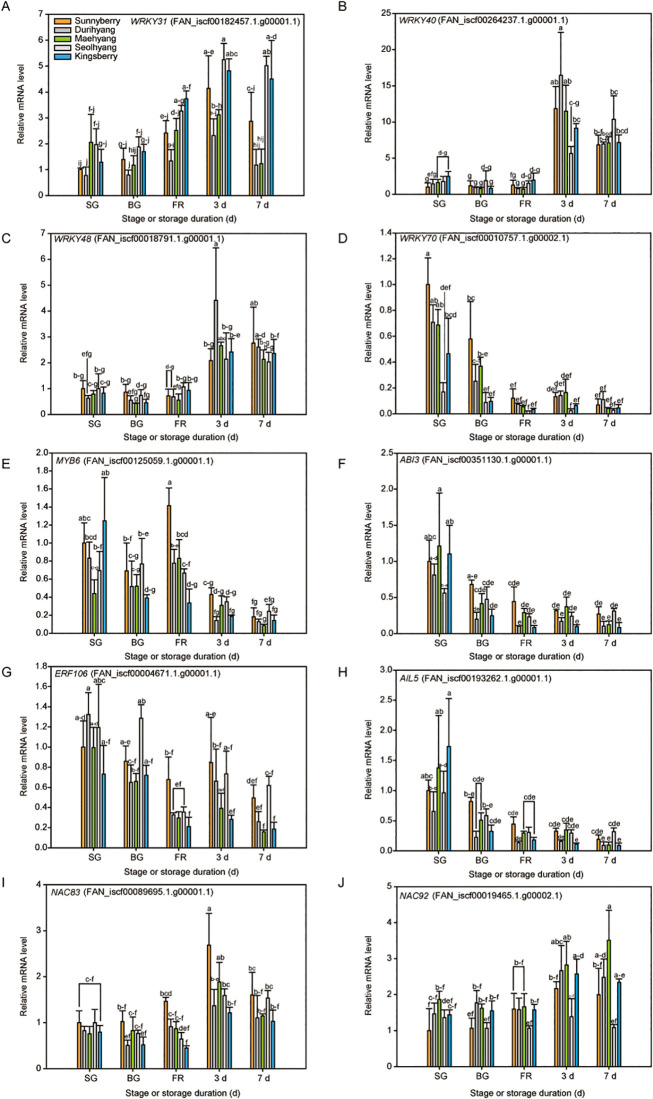
qPCR analysis of ten selected candidate genes related to the postharvest storability of strawberry fruit.The expression levels of (A) WRKY31, (B) WRKY40, (C) WRKY48, (D) WRKY70, (E) MYB6, (F) ABI3, (G) ERF106, (H) AIL5, (I) NAC83, and (J) NAC92 in five different strawberry cultivars at the small-green (SG), big-green (BG), and full-red (FR) fruit-development stages and during storage at 10°C for up to 7 d are shown. The data are expressed as the mean ± SD of three biological replicates. Letters indicate significant differences at P < 0.05 in two-way ANOVA followed by the post-hoc Tukey’s HSD. Statistics can be found in S14 Table.